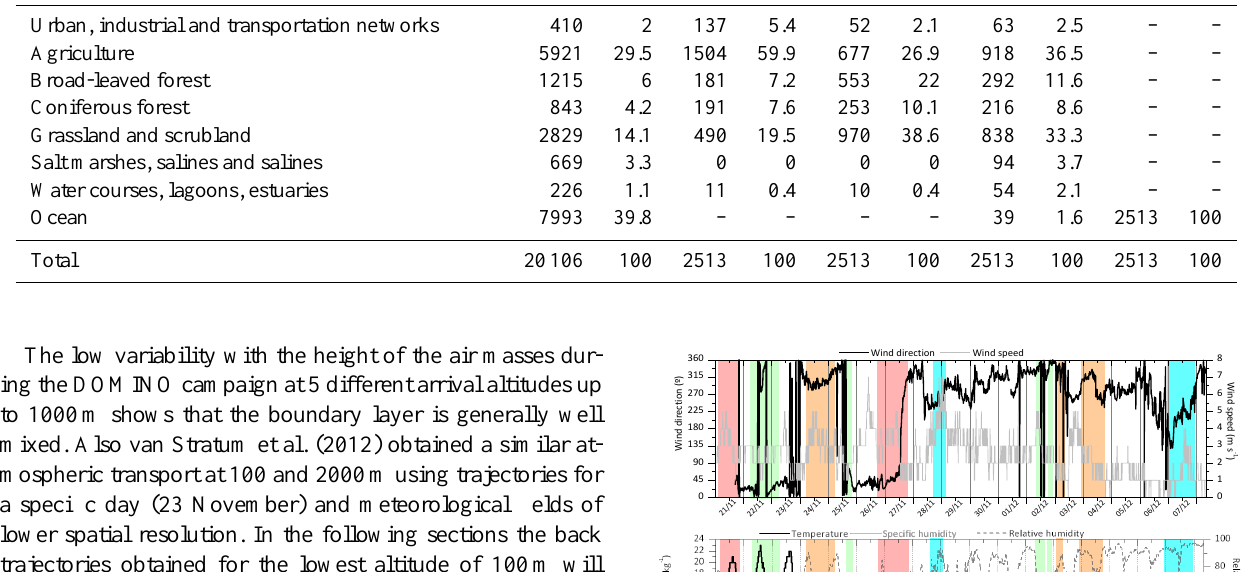
Table 2. Land use, total and by sectors of air mass origin. The analysis was carried out within a radius of 80km from the sampling site. Each column shows the area (km 2 ) of each land use and the percentage of total surface. Land use 80km radius